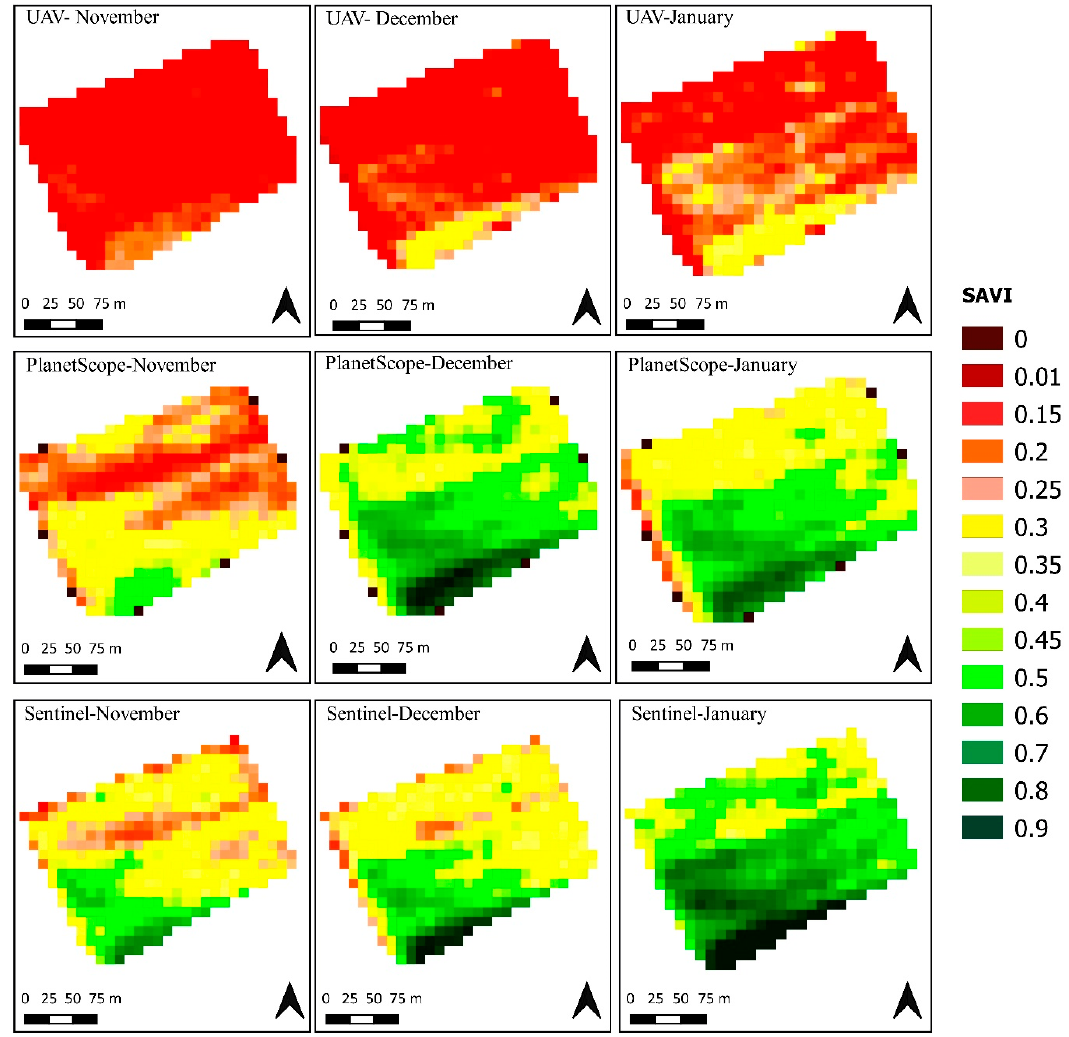
Figure 11. SAVI maps, showing onion crop with 10 m resolution, derived from the platforms UAV ( top ), satellite PlanetScope ( center ), and satellite Sentinel-2 ( bottom ).